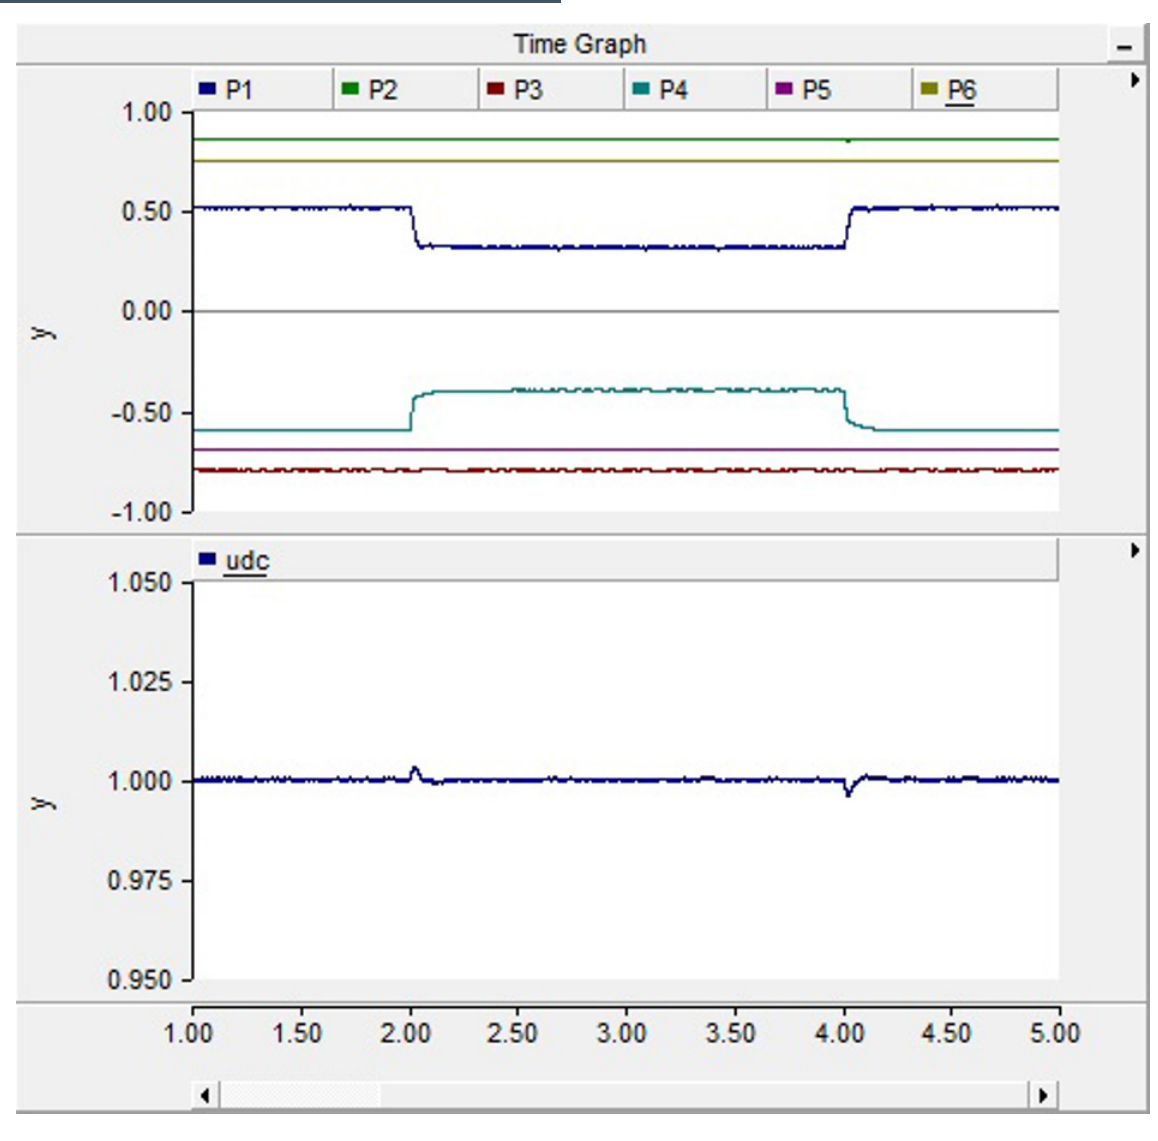
Figure 9. Responses when wind power changes